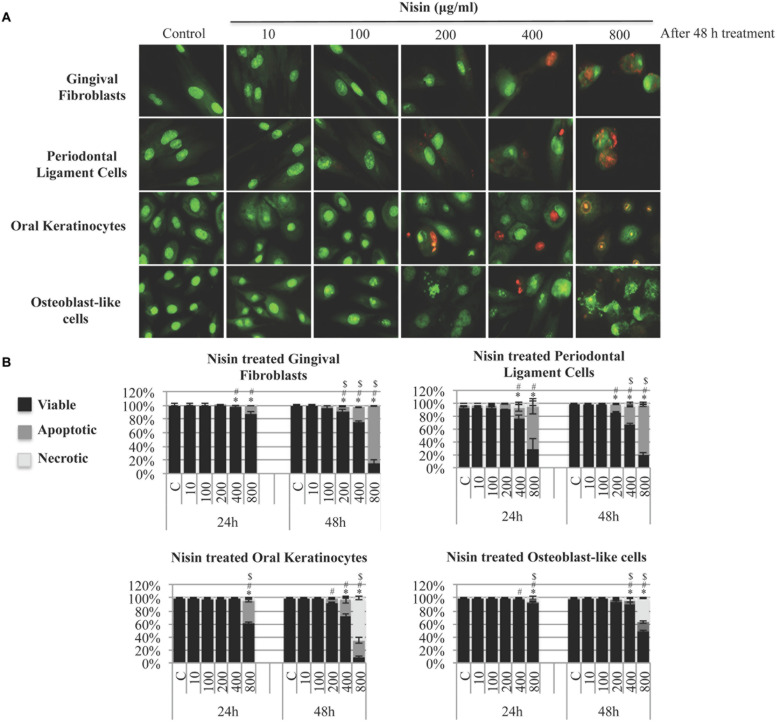
Nisin has minimal cytotoxicity to human cells relevant to the oral cavity. Primary human gingival fibroblast (GF) cells, periodontal ligament (PDL) cells, oral keratinocyte (OK) cells, and osteoblast-like cells were incubated with nisin (1–800 μg/ml) for 24–48 h on a 96-well microplate at 37°C. Cells were then stained with acridine-orange/ethidium-bromide (AO/EB) to evaluate cell viability, apoptosis and necrosis using epifluorescence microscopy. (A) Images of the cells after 48 h incubation period with nisin at different concentrations. (B) The cytotoxicity of nisin was quantified by counting viable, apoptotic and necrotic cells and expressed as bar graphs with heights representing mean % and error bars representing SD. AO (green) stained cells with intact membrane integrity. Early apoptotic cells stained green but contained bright green dots in the nuclei due to chromatin condensation and nuclear fragmentation. Late apoptotic cells stained with EB (orange) with apoptotic phenotypes. Necrotic cells stained orange but the nuclear morphology resembled the viable cells with absence of chromatin condensations. Mean values were calculated with SD. ∗,#,$ represent P < 0.05: significant differences from the control (nisin free) for viability, apoptosis and necrosis, respectively.